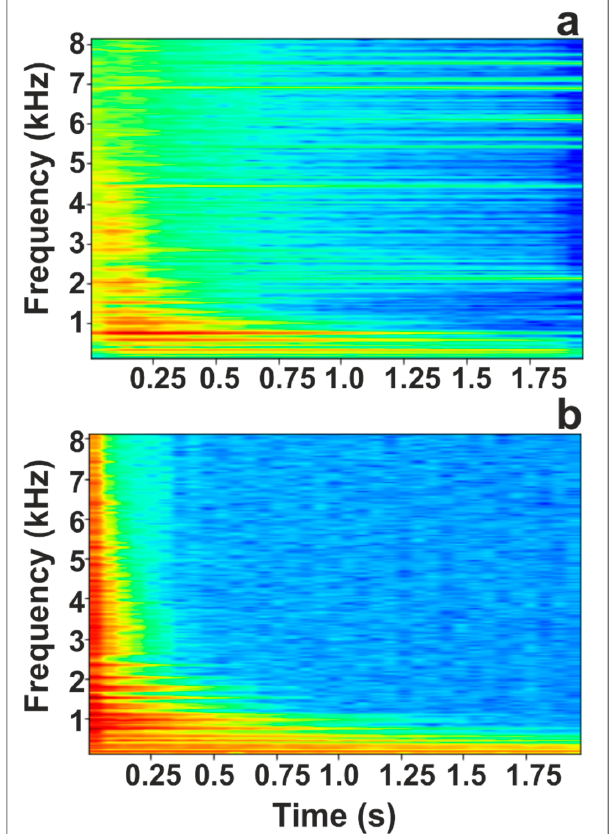
Figure 6. ( a ) Sound pressure spectrograms for the splash cymbal hit by a mf free stroke; ( b ) Velocity spectrogram for the splash cymbal hit by a mf free stroke.